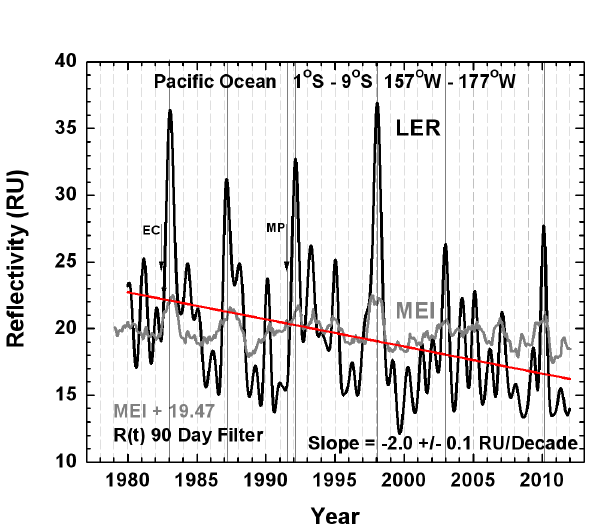
Fig. 14. LER time series (Black) compared with the offset MEI+19.47 (grey) for the Pacific region shown in Fig. 11 that has a large reflectivity